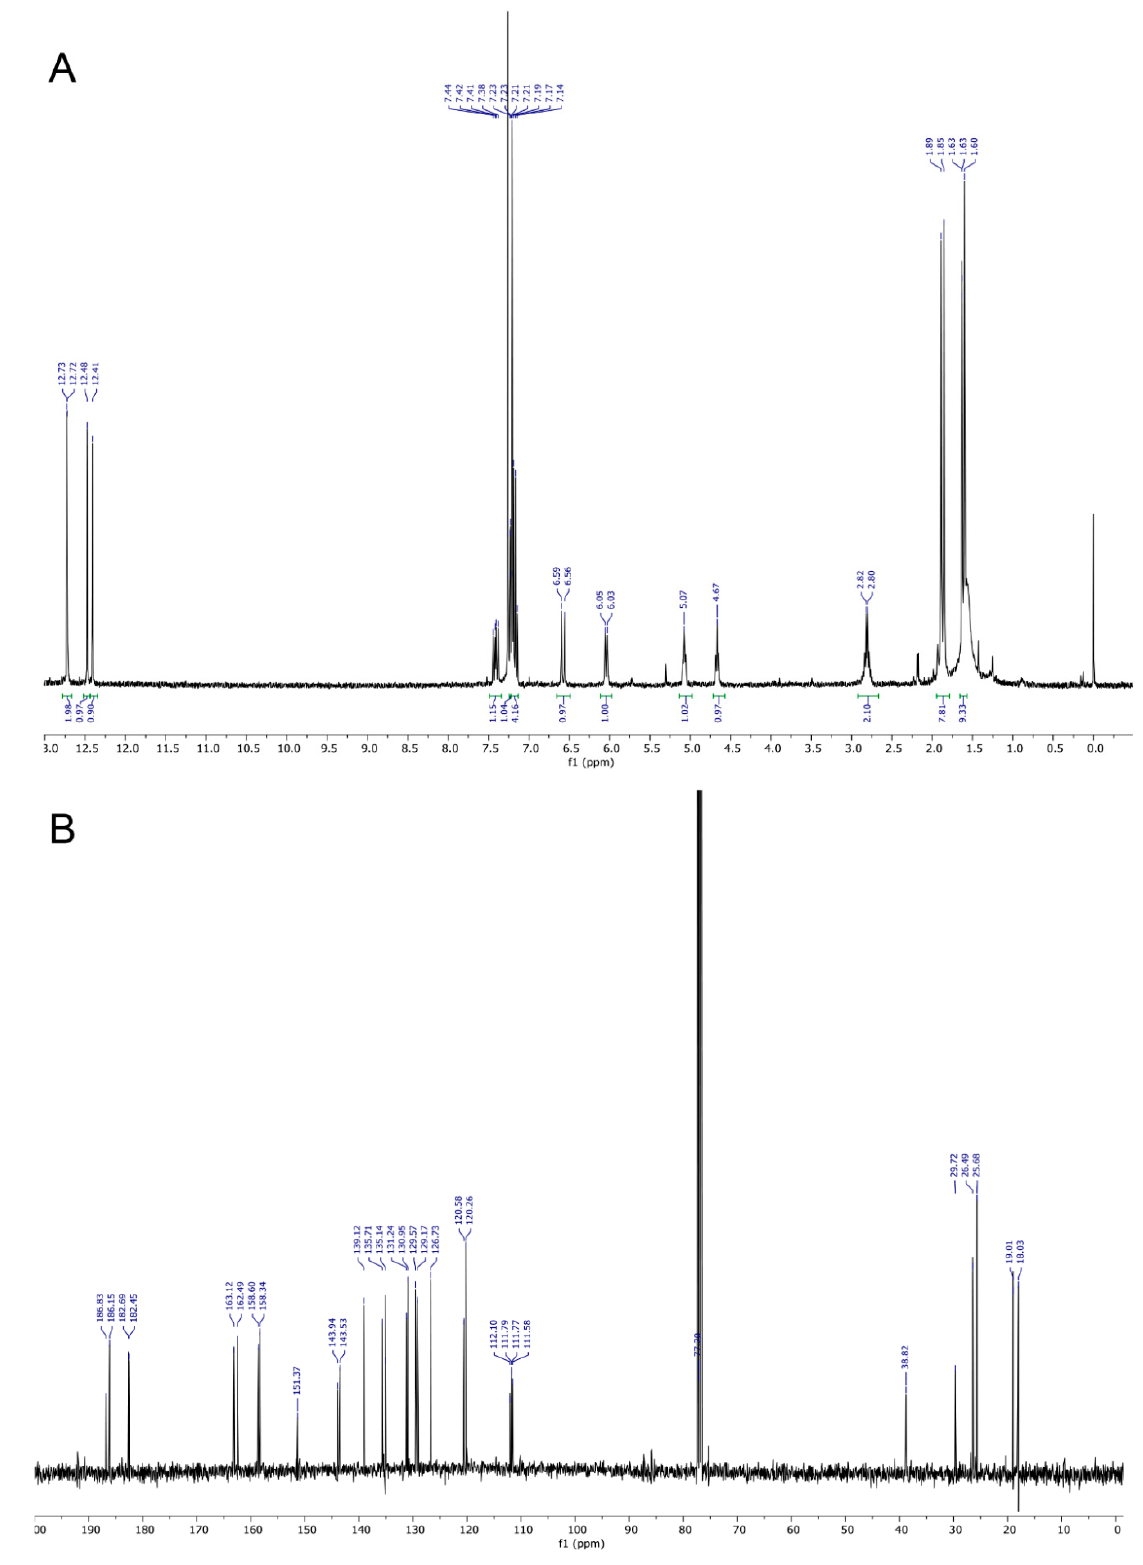
Figure 2. ( A ) 1 H NMR spectrum and ( B ) 13 C NMR spectrum of SK119, measured in CDCl 3 .